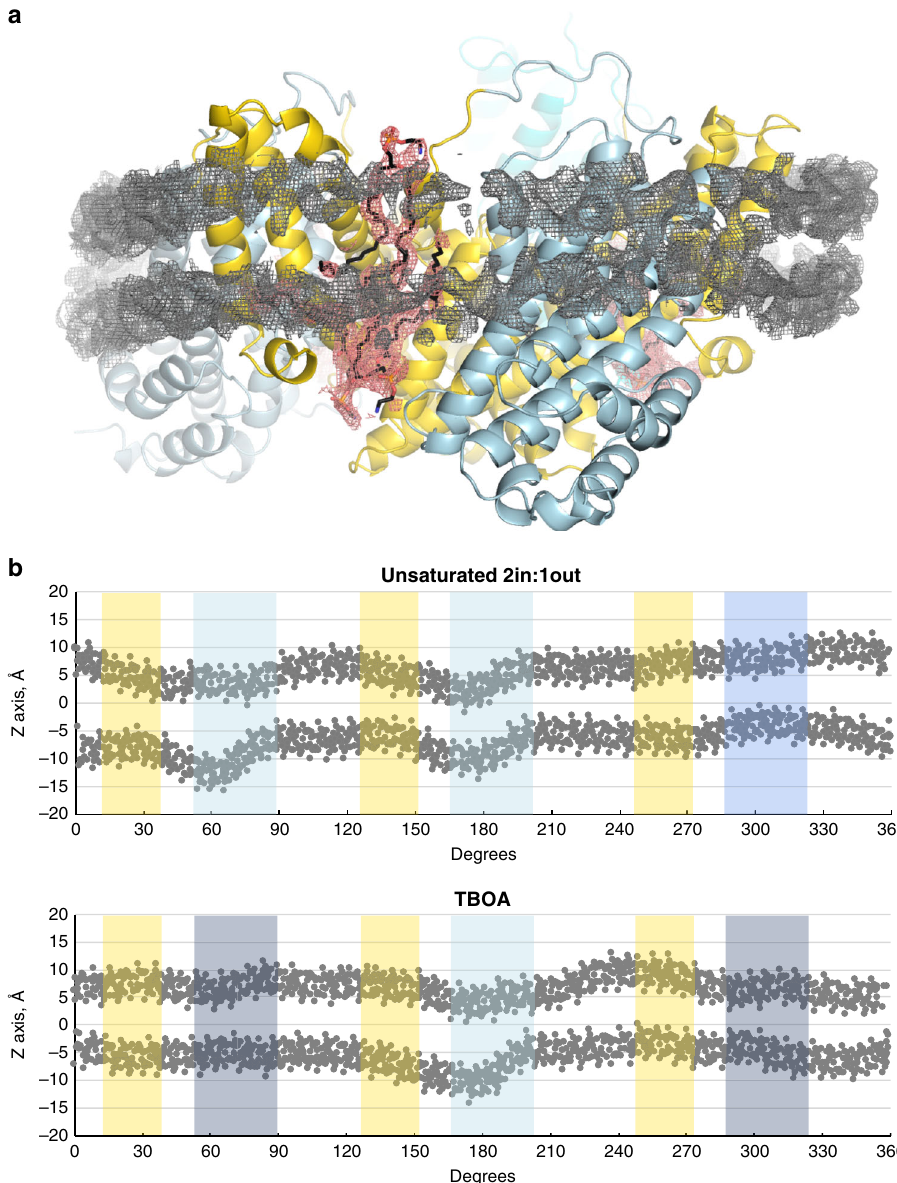
Fig. 4 Lipids and membrane deformation. a MSP2N2 (gray mesh, 3.5 σ ) and lipids (black sticks, salmon mesh, 3 σ ) in the Glt Tk structure determined in Na + -only conditions. Colors are the same as in Figs. 1 – 3. b Glt Tk trimers were oriented with the z -axis along the pseudo three-fold axis of the scaffold domains, and the y -coordinates of the atoms from the modeled MSP2N2 protein were plotted as a function of the position along the 360° perimeter. The vertical colored bars indicate where the belt covers the scaffold (yellow) and transport domains (shades of blue as in Fig. 1c). Source data are provided as a Source Data fi